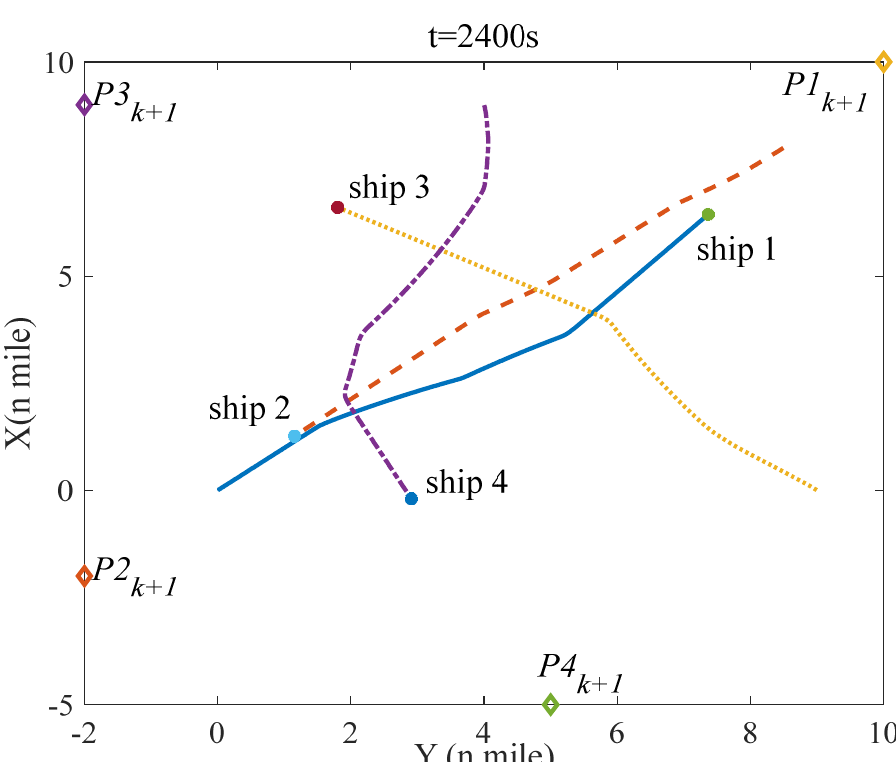
Figure 8. The situation of four ships at t = 1200 s in scenario 1.